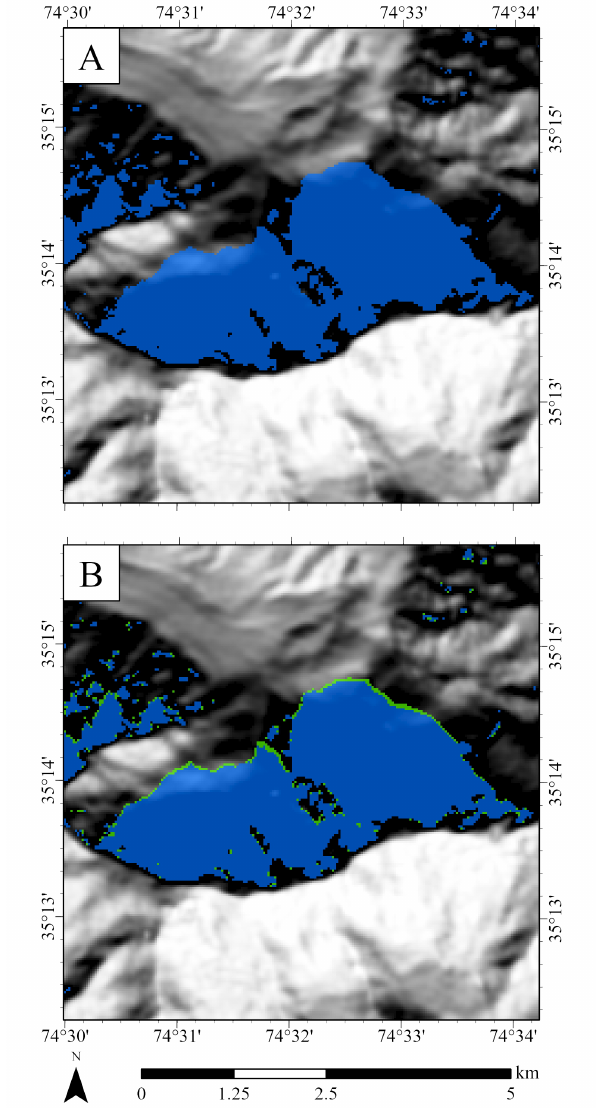
Figure 2. Cast shadow simulation results depicting two parameterization schemes in the upper region of the Diamir Basin on the northwestern side of Nanga Parbat on 15 September 2022 at 10:00 a.m. ( A ). Cast shadow depiction based upon the solar point-source assumption. Cast shadows are depicted in blue over the cos i image that depicts terrain self-shadowing. ( B ). Cast shadow accounting for the solar disk and differentiation of the umbra (blue) and penumbra (green) regions of the cast shadow. Cast shadows are depicted over the cos i image that depicts terrain